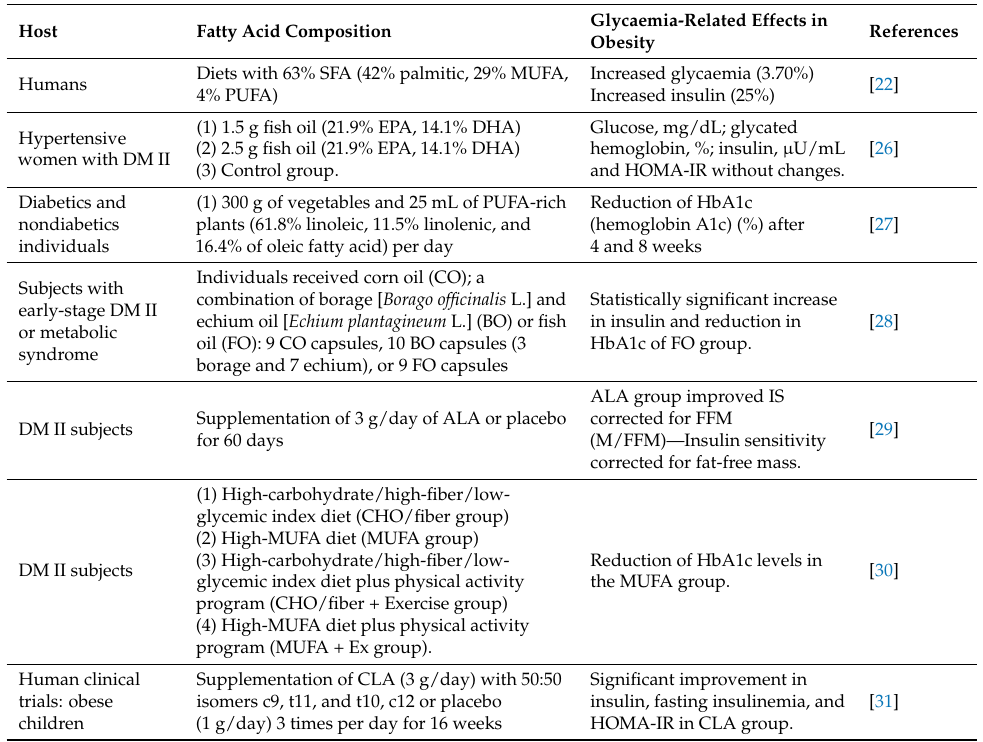
Table 1. Effects of different types of fatty acids on insulin resistance and associated comorbidities during human